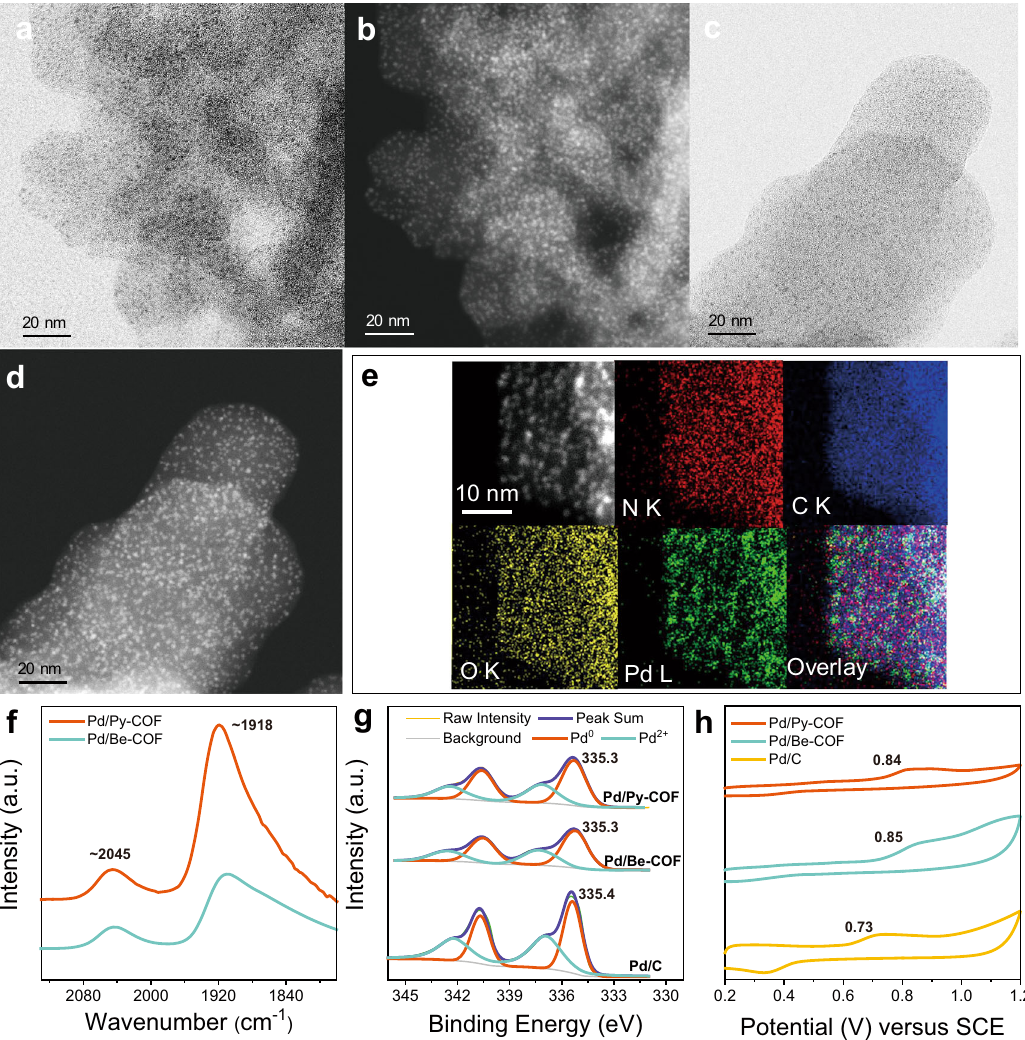
Fig. 2 Characterization of supported Pd NPs. a HRTEM image and b HAADF-STEM image of Pd/Py-COF. c HRTEM image and d HAADF-STEM image of Pd/Be-COF. e N, C, O, and Pd STEM-EDS maps and reconstructed overlay image for Pd/Py-COF. f In situ FTIR spectra of CO adsorption, g Pd 3 d XPS core- level spectra and h CO stripping voltammetry for Pd/COFs and